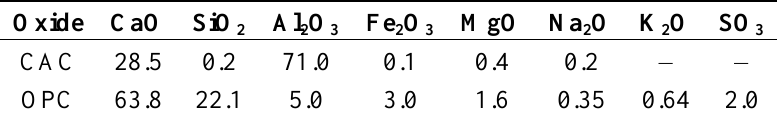
Table 1. Oxide composition of calcium aluminate cement (CAC) and ordinary Portland cement (OPC) (%).